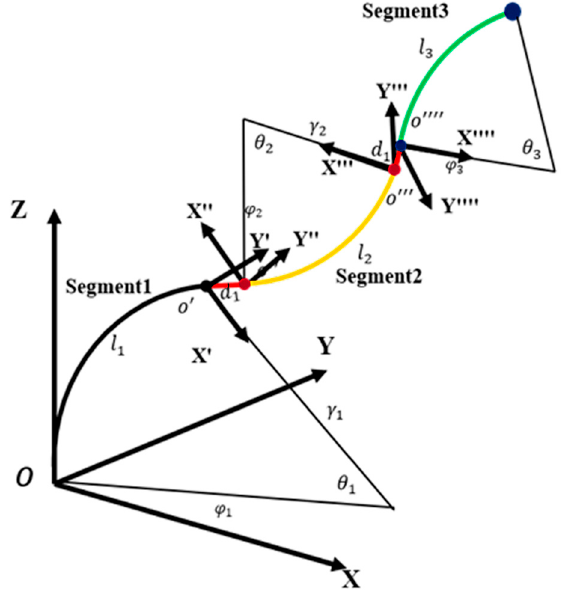
Figure 8. The coordinate system of the three-segment continuum robot.